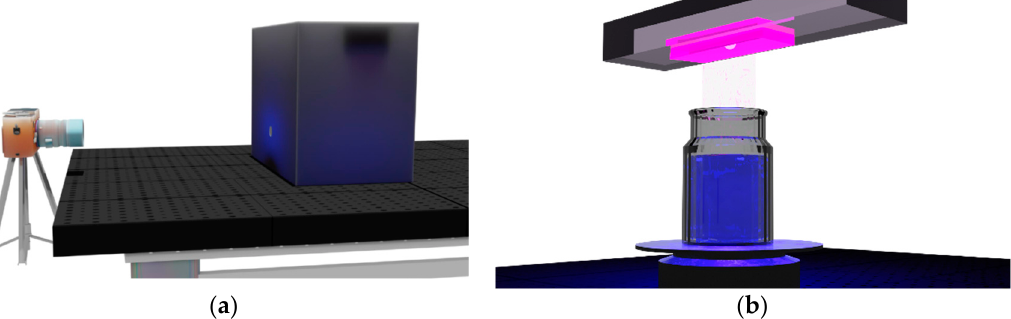
Figure 2. ( a ) Illustration of the experimental setup for taking digital images. A digital camera was remotely controlled. The WbLS sample was placed in a black box. There was a hole in the front of the box, and the light coming out through hole was photographed. ( b ) Schematic diagram showing the inside of the black box. A cylindrical quartz container was placed on top of the rotating disk, which can rotate at constant speed. UV light illuminates the sample from the top of the container to the